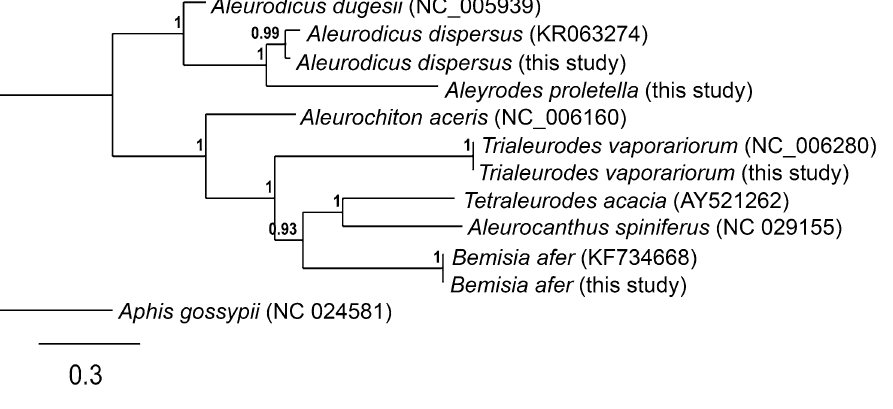
Figure 4. Maximum-likelihood tree of full mitogenomes (13 protein coding genes) based on complete mitogenome sequences excluding tRNA, rRNA and control regions of Aleurodicus dispersus , Aleyrodes proletella , Bemisia afer and Trialeurodes vaporariorum from Kenya including Bemisia tabaci mitogenome available in GenBank, with Aphis gossypii mitogenome as an outgroup. Branchsupport was based on 1000 bootstrap replicates. Numbers in the brackets represent the GenBank accession numbers.